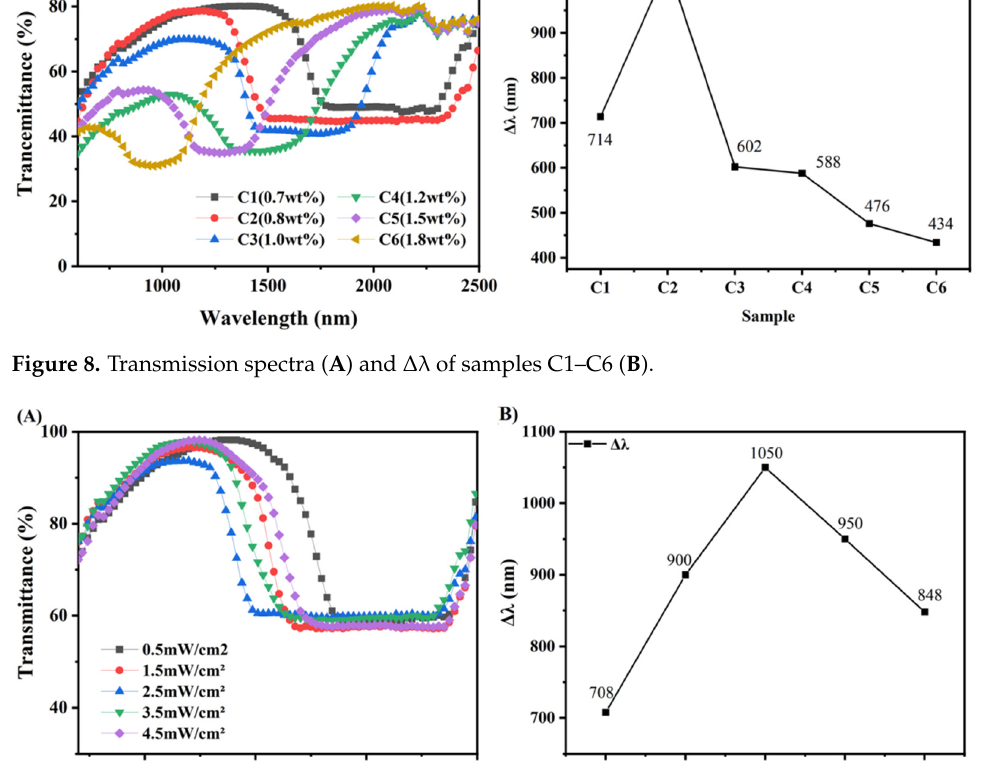
Figure 10. Bonding strength of PDLC, PD&SLC and PSLC.